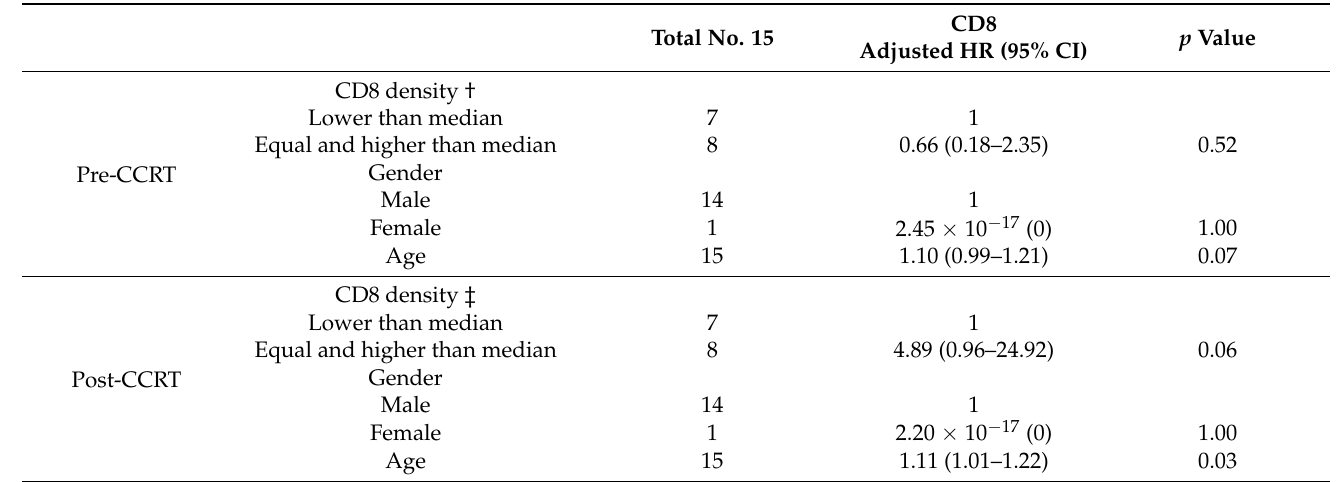
Table 4. Multivariate analysis of factors associated with overall survival in the 15 ESCC patients with paired specimens before CCRT by median of CD8